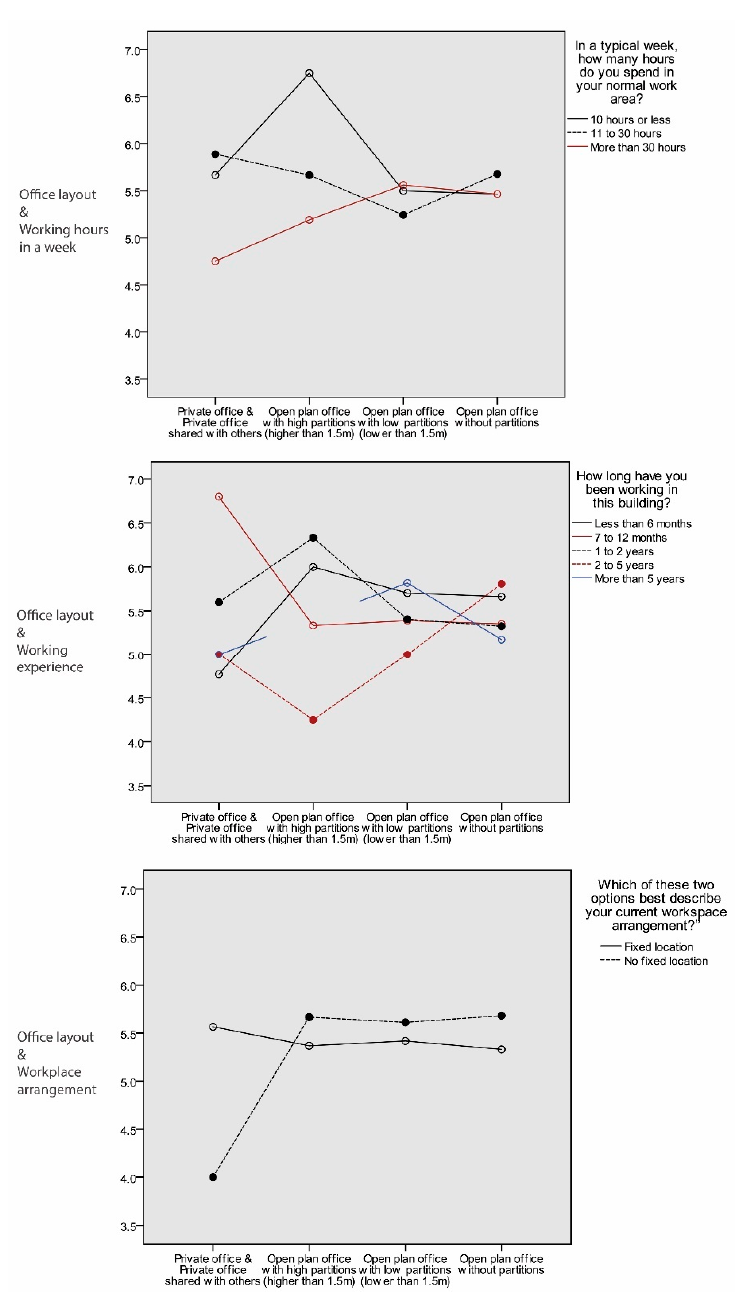
Figure 3. Two-way ANOVA results of office layout influence on perceived productivity by working hours and experience and workplace arrangement (4 = neither negative nor positive, 7 = very positive).